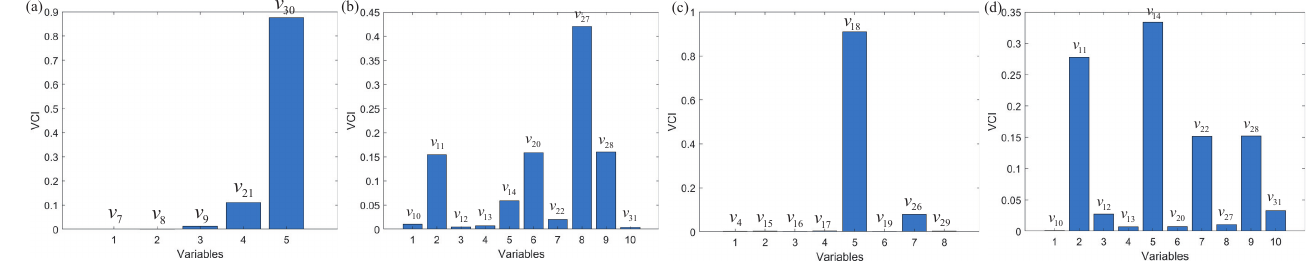
Figure A1. The variable isolation results in TE process. ( a ) Block 2 with IDV (6); ( b ) Block 3 with IDV (6); ( c ) Block 4 with IDV (6); ( d ) Block 3 with IDV